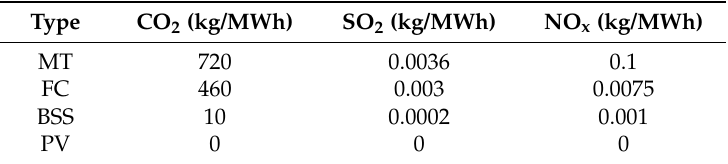
Table 6. DERs generated